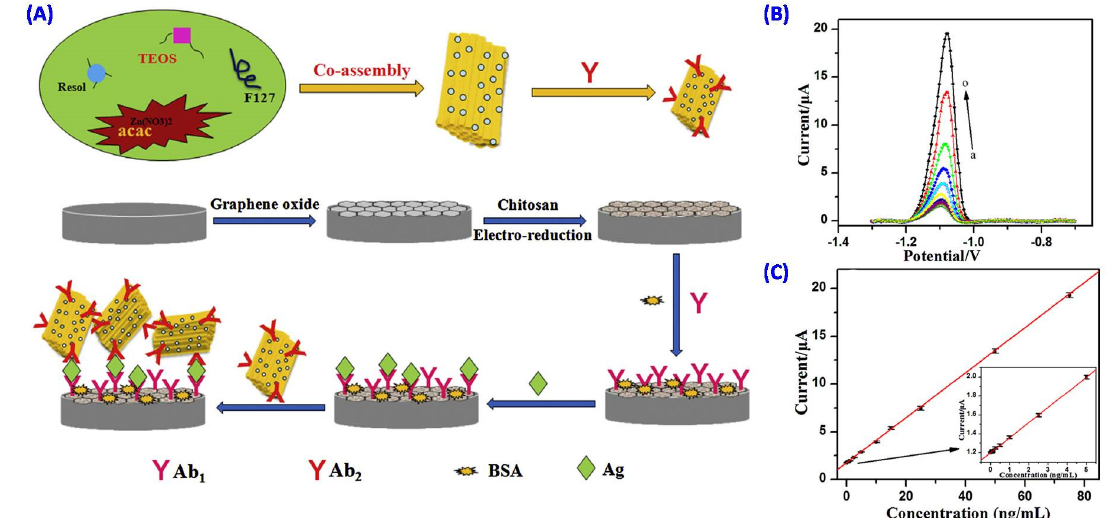
Figure 3. ( A ) Schematic representation of the stages involved in the preparation of Ab 2 -OMCSi-Zn bioconjugate and the sandwich-type immunosensor; ( B ) DPV recorded for the immunosensor towards various PCT concentrations (0.005, 0.01, 0.05, 0.075, 0.1, 0.25, 0.5, 1, 2.5, 5, 10, 15, 25, 50, 75 ng/mL) in pH 6.0 acetate buffer. ( C ) Calibration plot obtained for PCT using the immunosensor [25].